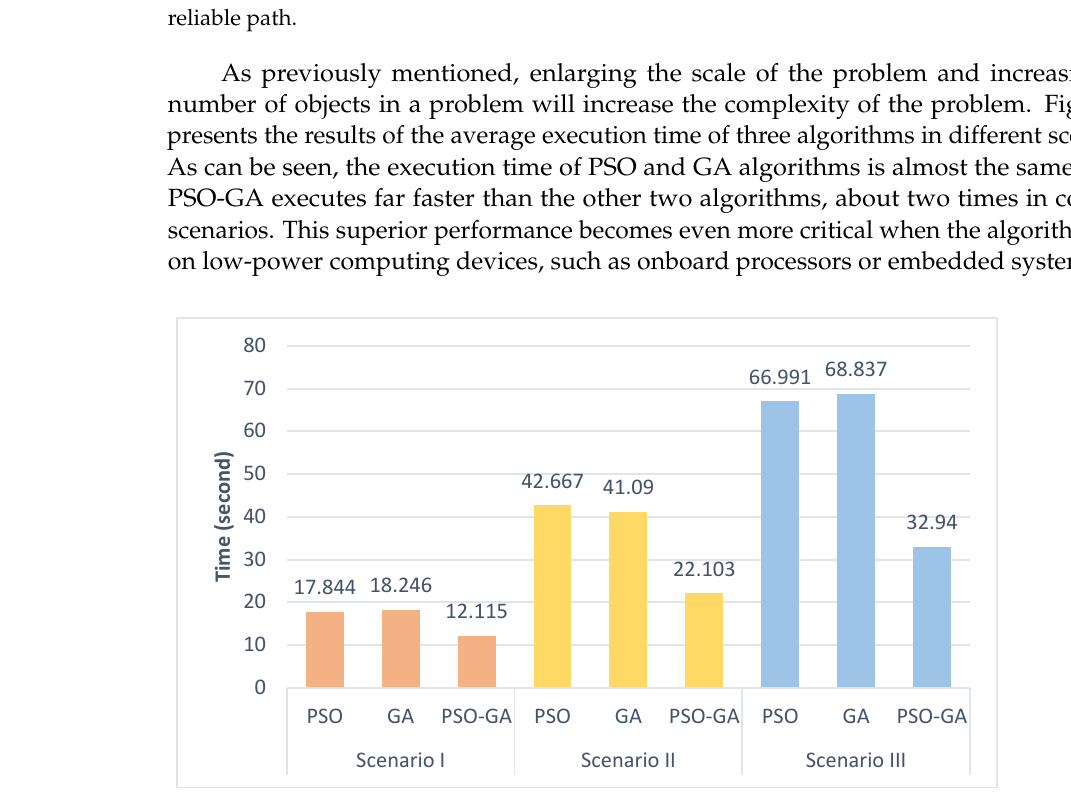
Figure 16. Comparison of the algorithms’ execution time in different scenarios.